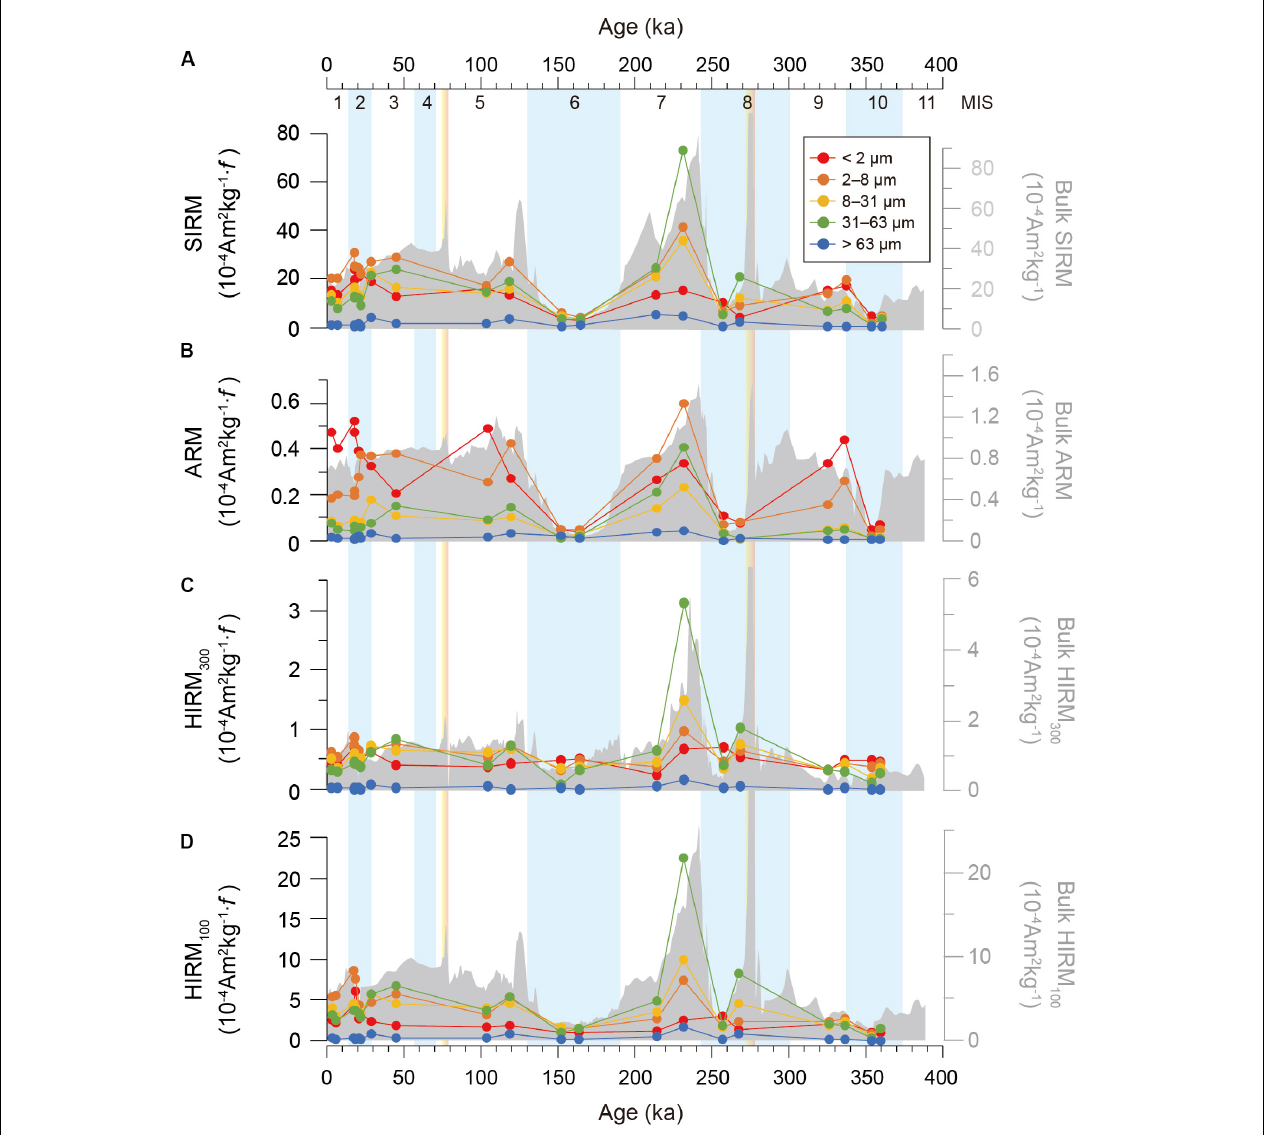
FIGURE 2 | Magnetic concentration parameters of bulk and size-fractionated samples from NPGP1302-1B. (A) Saturation isothermal remanent magnetization (SIRM); (B) anhysteretic remanent magnetization (ARM); (C) hard ( > 300 mT) IRM (HIRM 300 ); and (D) hard ( > 100 mT) IRM (HIRM 100 ). Values are mass-weighted by multiplying fractional abundance (%). For comparison, the bulk values from Shin et al. (2018) are shown as gray shaded area. Marine Isotope Stages (MIS) are labeled as numbers on the top. Volcanic ash layers at ∼ 80 and ∼ 270 ka are marked by orange